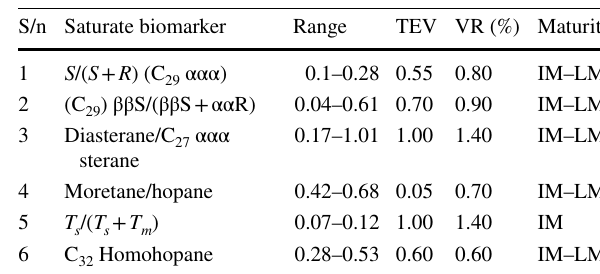
Table 7 Saturate biomarker ratio, thermal equilibrium value